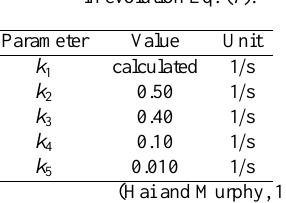
Table 1 Passive and active material parameters in Eqs. (5), (6), (9), and (10).